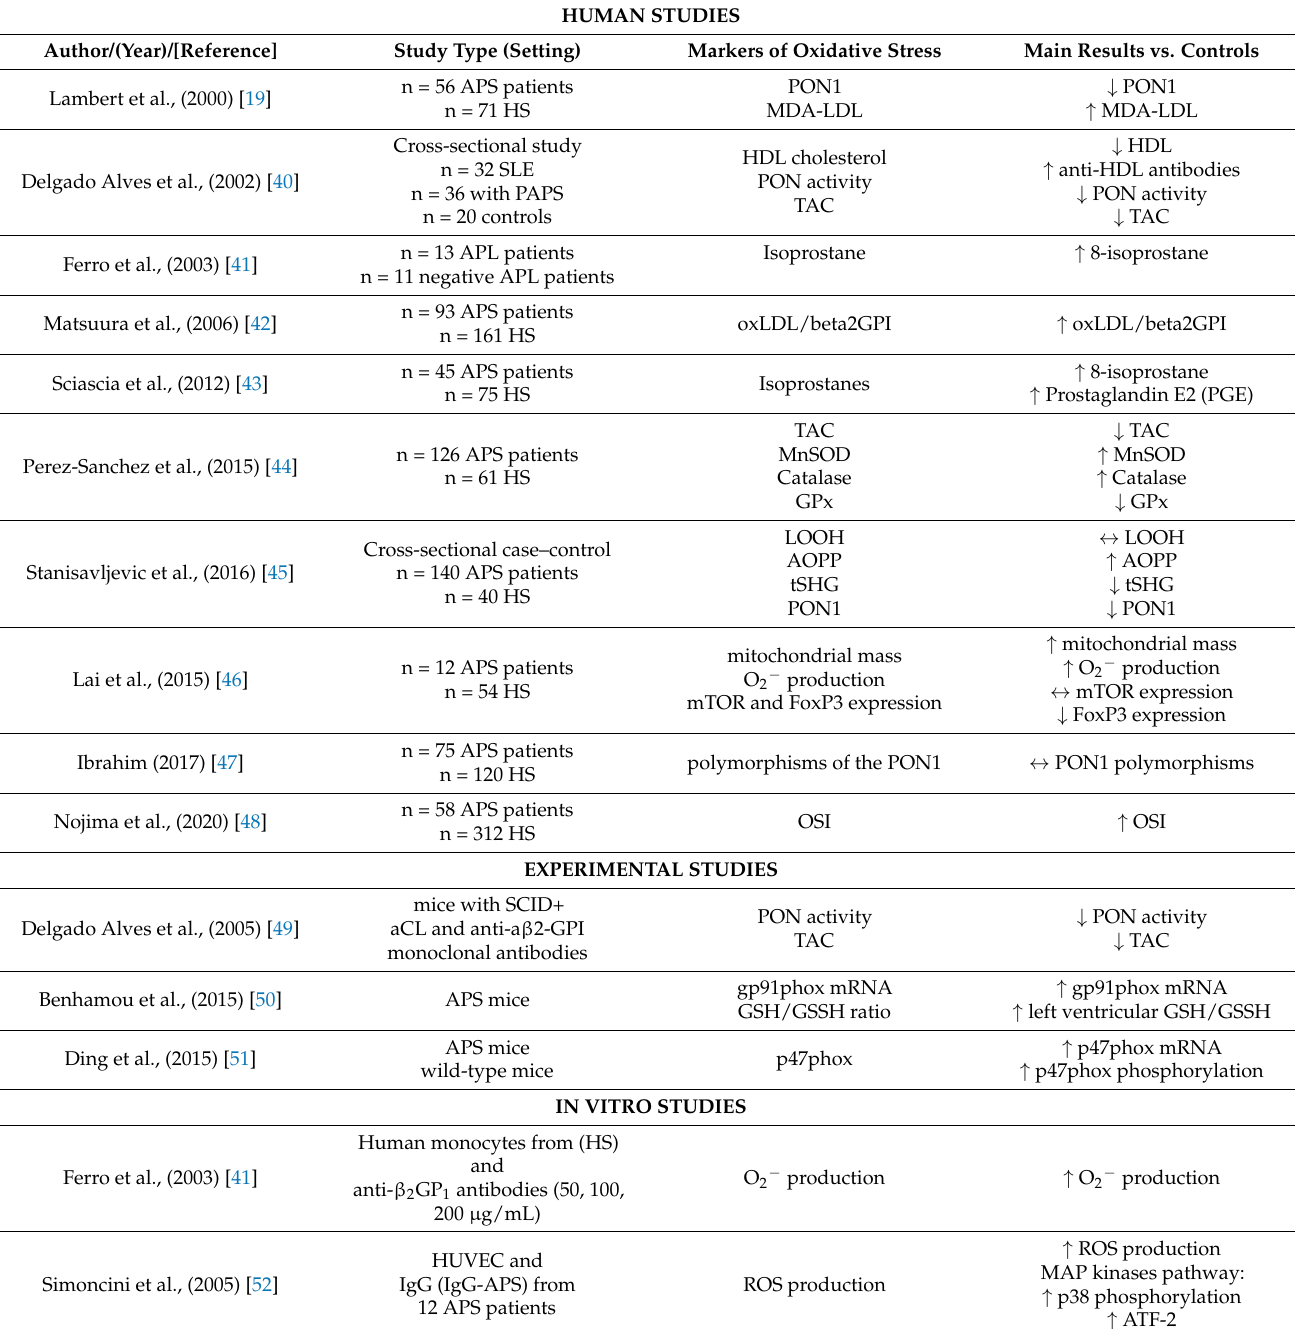
Table 1. Clinical, experimental, and in vitro studies describing changes of biomarkers of oxidative stress in APS patients.